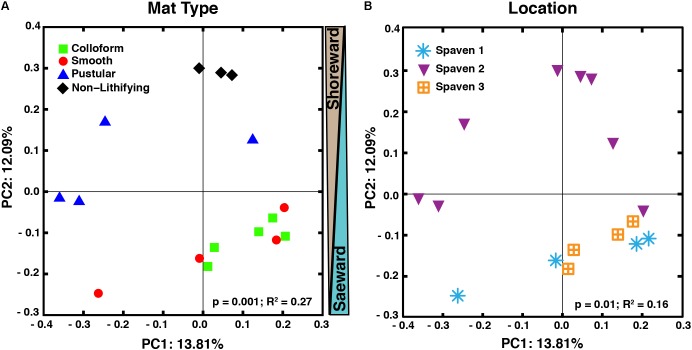
Comparison of microbial diversity between lithifying stromatolite-forming mats and non-lithifying microbial mats in Spaven Province. Principal coordinates analysis plotting the unweighted Unifrac distances between samples according to mat type (A) and the three collection transects (Spaven 1, 2, 3) within Spaven Province (B).